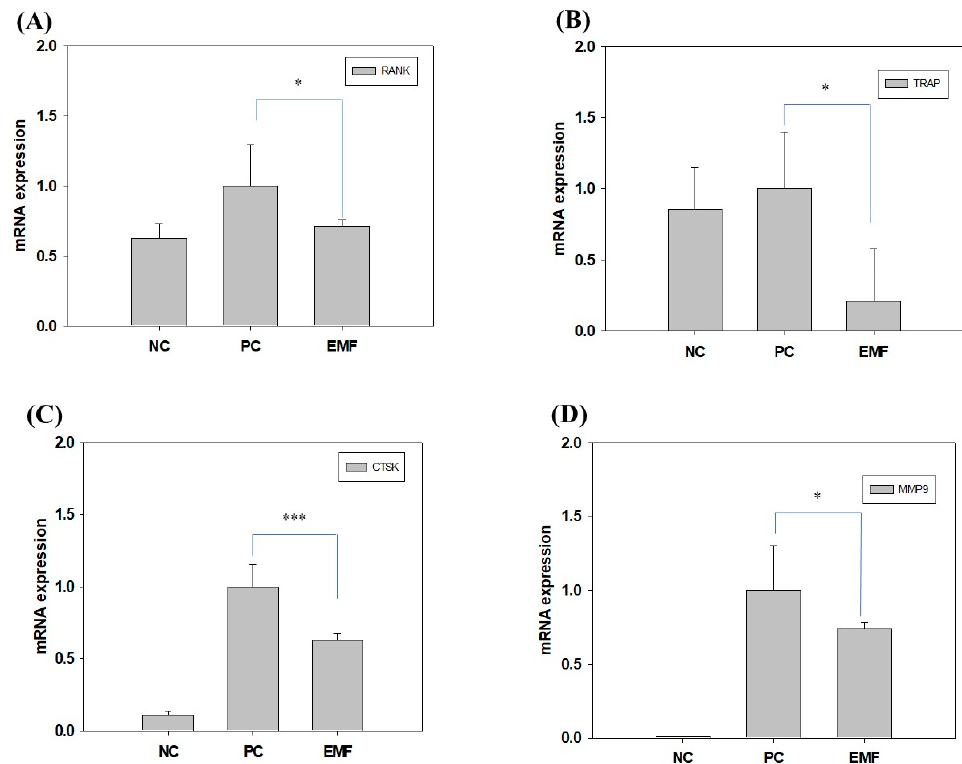
Figure 4. EMF regulates the expression of osteoclastogenic markers. Expression levels of ( A ) RANK, ( B ) TRAP, ( C ) CTSK, and ( D ) MMP9 were determined by RT-qPCR in Raw 264.7 cells differentiated for 4 days in differentiation media (with RANKL) with or without EMF exposure. NC, cells grown in growth media (undifferentiated); PC, cells grown in differentiation media (with RANKL); EMF, cells grown in differentiation media (with RANKL) with EMF exposure. The symbols * and *** indicate significant differences with p < 0.05 and p < 0.005, respectively. 2.4. Effect of EMF Exposure on Proinflammatory and Inflammatory Cytokine Levels We measured mRNA expression levels of proinflammatory and inflammatory cytokine markers by RT-qPCR in Raw 264.7 cells and found that the mRNA levels of TNF- α , IL-1 β , and IL-23 were decreased by EMF exposure compared to the positive control group (Figure 5).